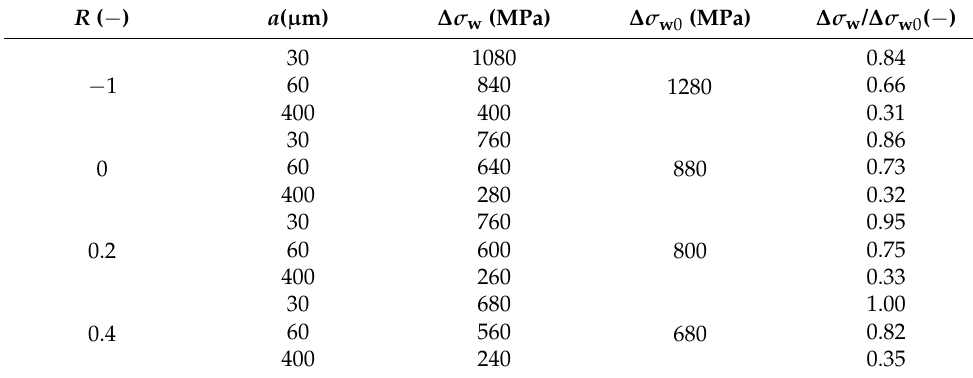
Table 2. Ratios of the fatigue limits of the slit and smooth specimens ∆ σ w / ∆ σ w0 .